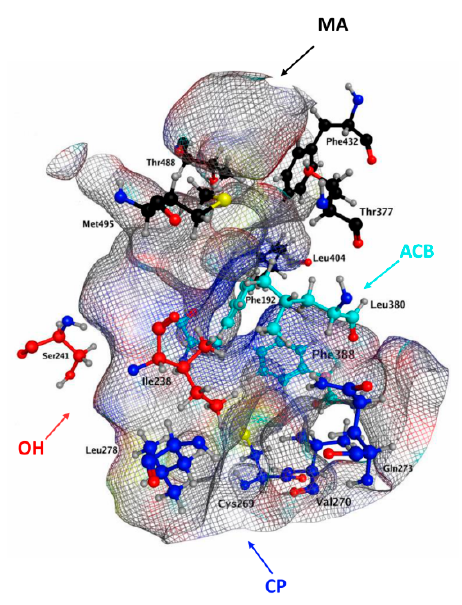
Figure 7. 3D channels of hFAAH obtained through the MOE software. The purported key residues in the different cavities are shown as sticks. For MA, in black: Thr377, Leu404, Phe432, Thr488 and Met 495. For ACB, in cyan: Phe192, Leu380 and Phe388. For OH, in red: Ile238 and Ser241. For CP, in blue: Cys269, Val270, Gln273 and Leu278.